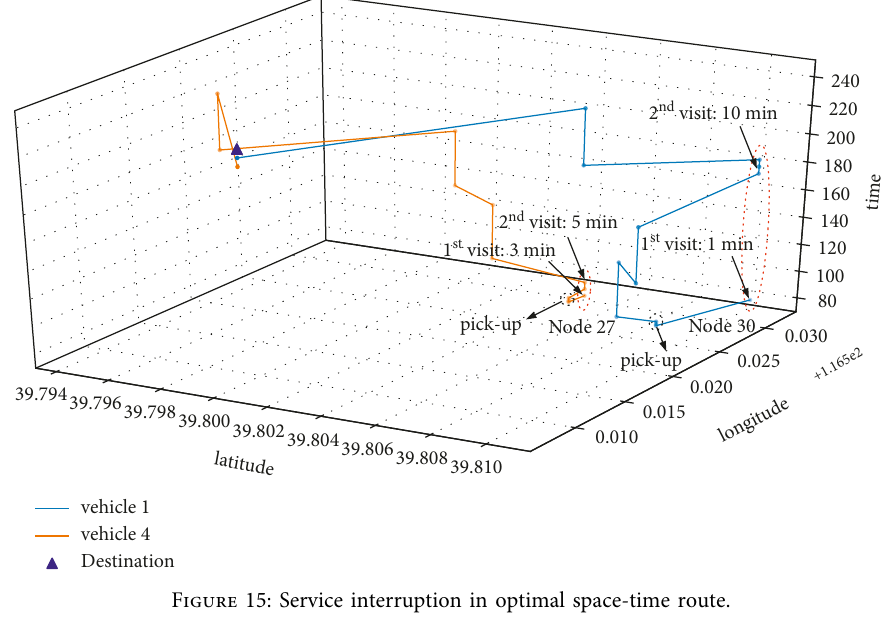
Figure 15: Service interruption in optimal space-time route.